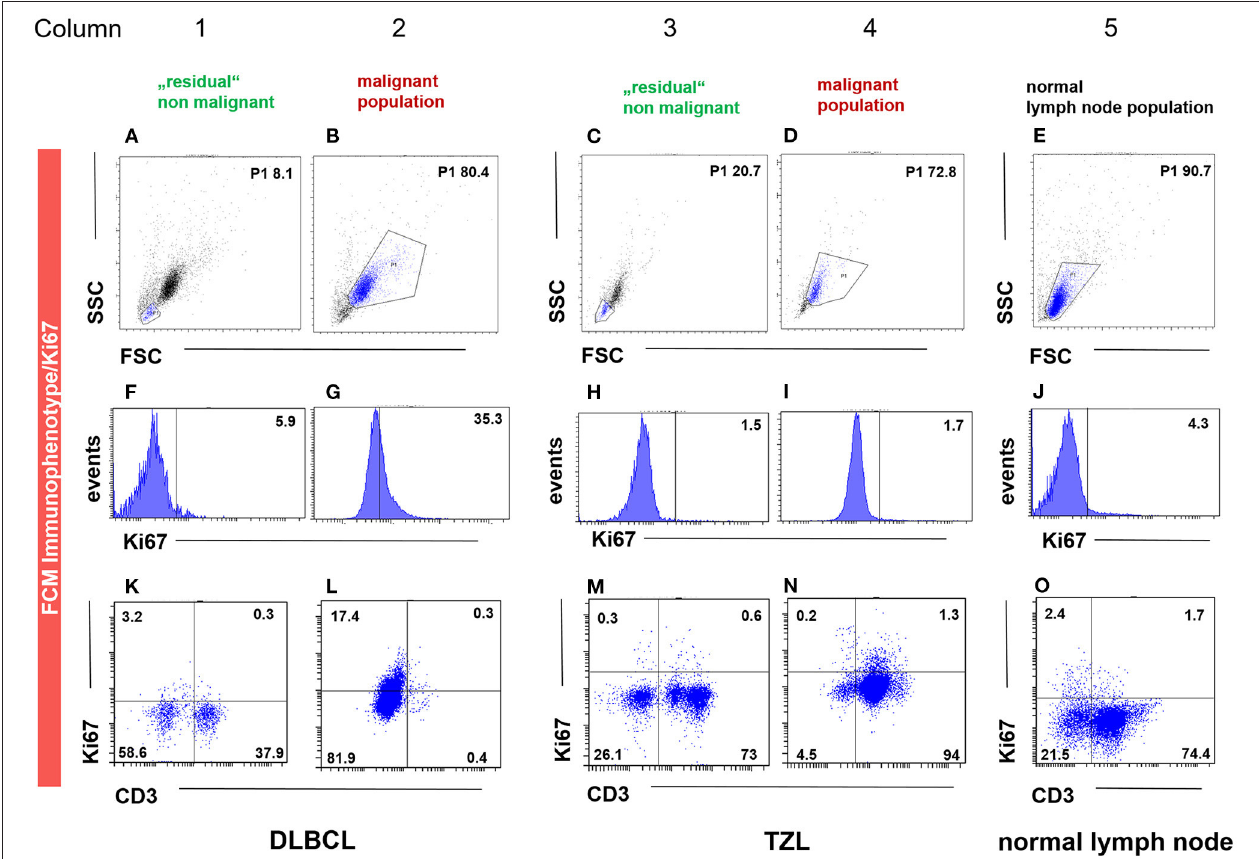
FIGURE 1 | FCM immunophenotyping showing the malignant (column 2, 4), the “physiologic” non-malignant (column 1 and 3) and the healthy lymph node (column 5) population gated by FSC/SSC (P1) (A–E) , Ki-67 and CD3 expression in histogram (F–J) and dot plot (K–O) in three representative patient samples. The population in the P1 gate (FSC/SSC) is marked in blue (A–E) , being the same as in the subsequent dot plots of the respective column. The P1 gate, hence the population, is chosen due to size and granularity and life/ dead discrimination. For the DLBCL (column 1–2) and the TZL (column 3–4) cases, the “physiologic” non-malignant populations are shown in column 1 and 3, whereas the corresponding malignant immunophenotype and Ki-67 expression are depicted in column 2 and 4. The patient in column 1 and 2 is a case of CD3 − (L) Ki-67 intermediate (35.3%, G) DLBCL gated by the malignant population of 80.4% based on FSC/SSC (P1) (B) . The remaining “physiologic” non-malignant population is in this case represented by FSC/SSC (P1) 8.1% (A) , showing low Ki-67 expression (5.9%, F) and a mixed expression for CD3 (38.2%, K). The patient in column 3 and 4 is a case of CD3 + (N) Ki-67 low (1.7%, I) TZL gated by the malignant population of 72.8% based on FSC/SSC (P1) (D) . The remaining “physiologic” non-malignant population is in this case represented by FSC/SSC (P1) 20.7% (C) , showing low Ki-67 expression (1.5%, H) and a mixed expression for CD3 (73.6%, M). The patient in column 5 is a representative example of healthy lymph node material represented by FSC/SSC (P1) 90.7% (E) , showing low Ki-67 expression (4.3%, J) and a mixed expression for CD3 (76.1%, O).